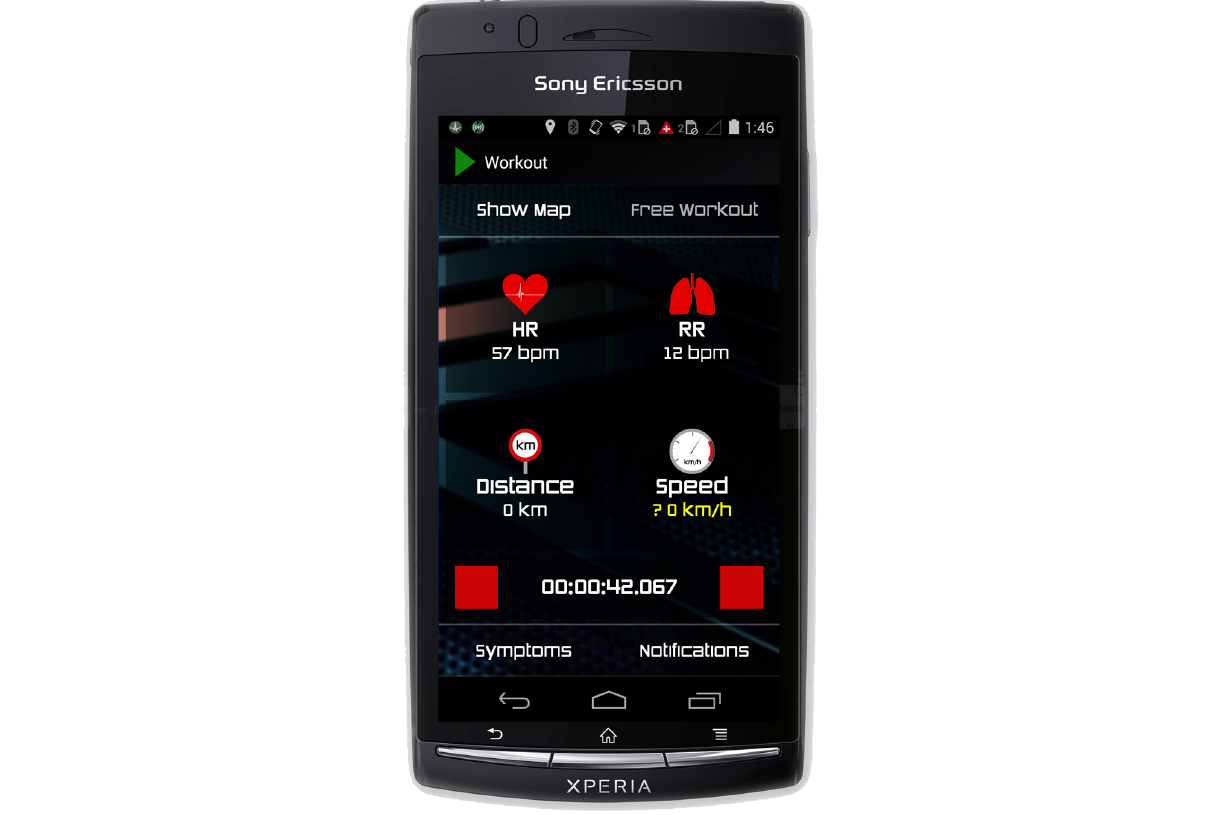
Figure 2. Custom mobile app